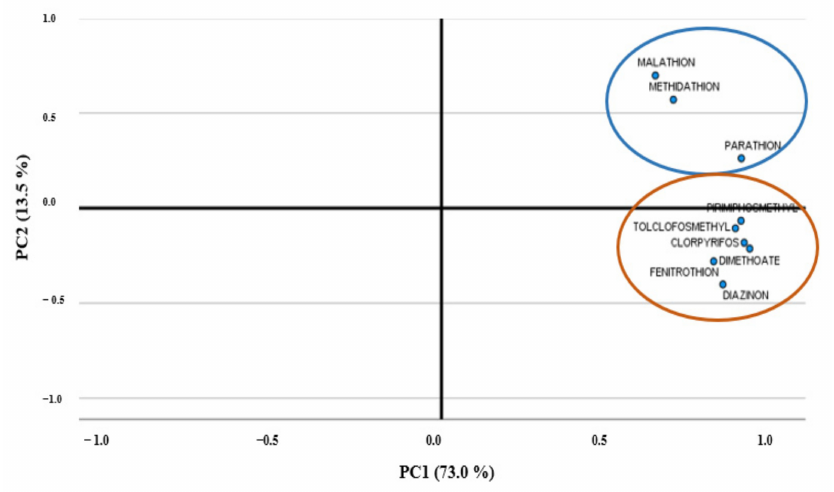
Figure 7. Principal component analysis: loading plot for the first and second principal components